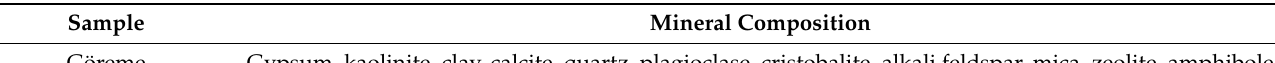
Table 1. Results of the Qualitative Mineral Test on the tuff stone samples from Göreme, Ürgüp, and Hallaç.